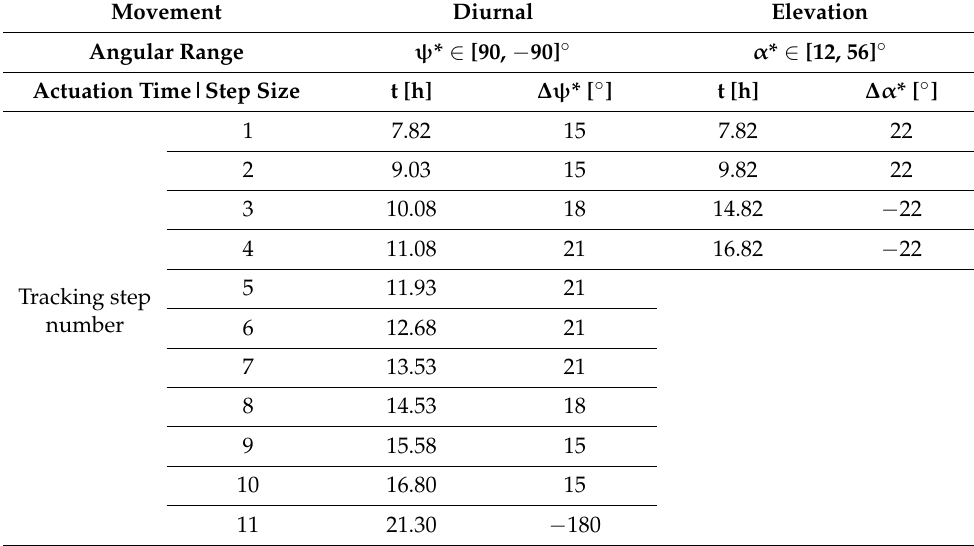
Table 6. Tracking program